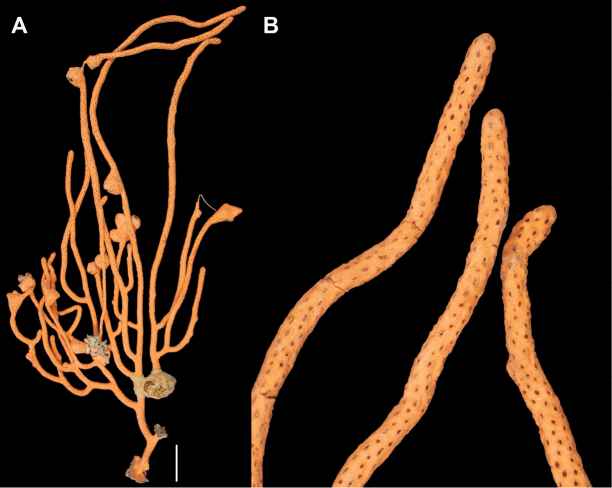
Chromoplexauramarki, SBMNH 423060 (Neotype). A This specimen, measuring 24–26 cm at greatest length, bears two different types of barnacle, a species that appears to be that of an acorn barnacle (forming the galls on this specimen), and clusters of a barnacle species that appears to be a “Lepas-type.” The sclerites from this colony aligned with known specimens of C.markiB Branch tips at greater magnification.